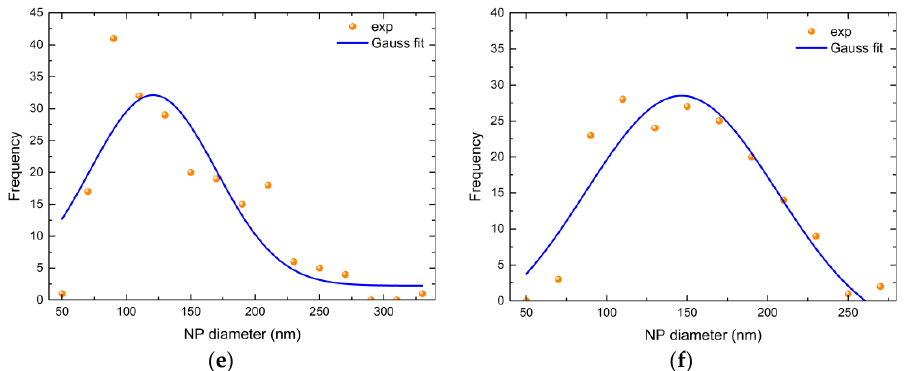
Figure 9. Two- and three-dimensional AFM images and nanoparticle size distribution diagrams for two areas of a 13.5 nm Ag film (Ag #1): ( a , c , e ) the laser-annealed area with a fill spacing of 0.05 mm; ( b , d , f ) the area irradiated with a 0.0125 mm fill spacing. Figure 10 corresponds to the same 13.5 nm Ag film (Ag #1) but illustrates an AFM image of the area irradiated with a frequency of 50 kHz and a 0.05 mm fill spacing. In contrast to Figure 9a, which shows the morphology of the area irradiated with the same fill spacing (0.05 mm) but a different frequency (60 kHz), one can see a bimodal distribution of scattered nanoparticles without any agglomerates. This indicates that complete nanostructuring took place under those laser settings. The lower frequency seems to have induced thermal energy deeper in the sample, leading to a bimodal distribution of both larger and smaller scattered nanoparticles.